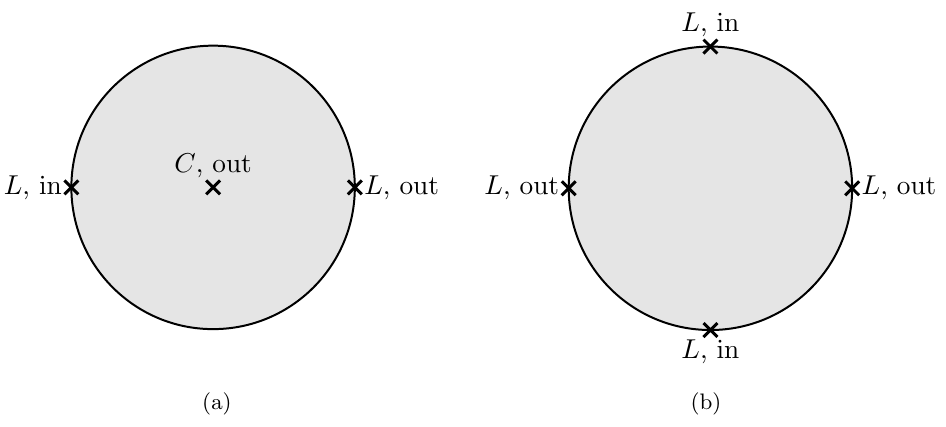
Figure 1 . (a) Worldsheet diagram of closed string emission by a long string at tree level. (b) Worldsheet diagram for the scattering of a pair of long strings at tree